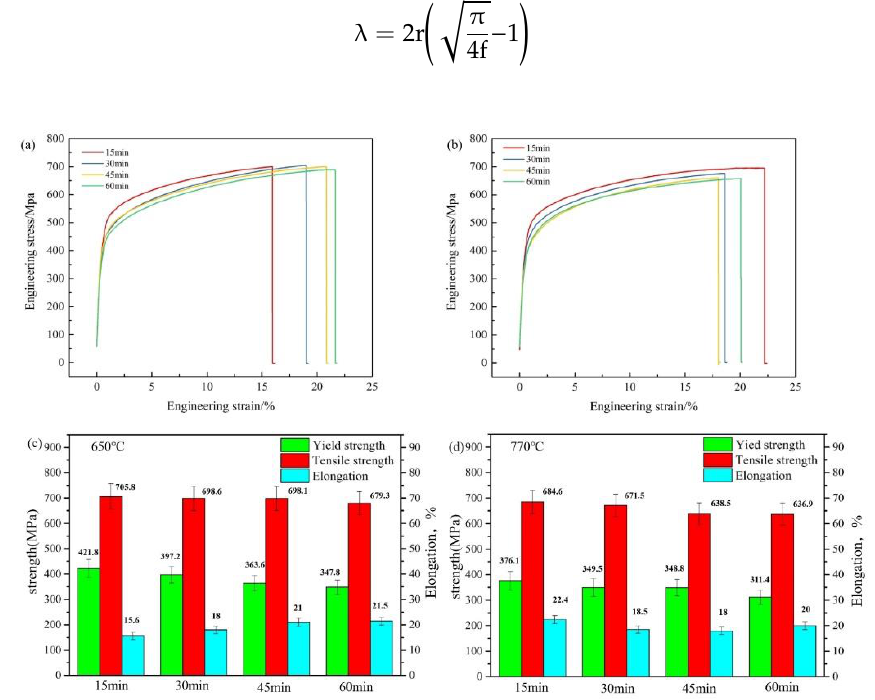
Figure 13. Engineering tensile stress-strain curves and mechanical properties of Cu-2.7Be sheets annealed at ( a ), ( c ) 650 ◦ C and ( b ), ( d ) 770 ◦ C for di ff erent time.